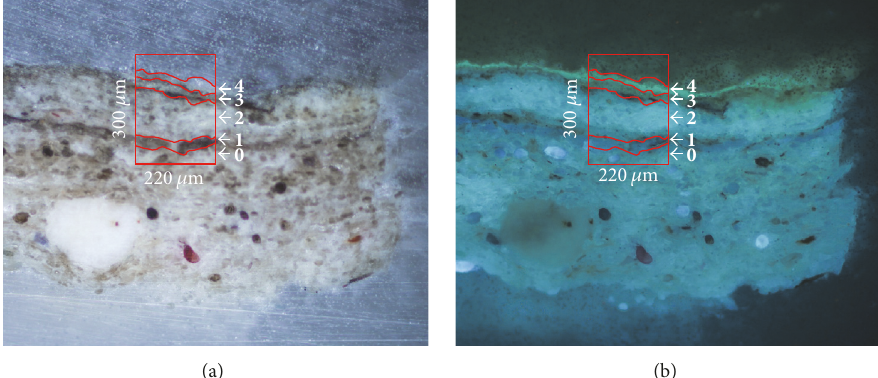
Figure 9: Cross-section microphotographs of sample BC1 embedded in KBr, (a) image under visible light; (b) image under UV illumination. The red box indicates the selected area for 𝜇 FTIR-ATR